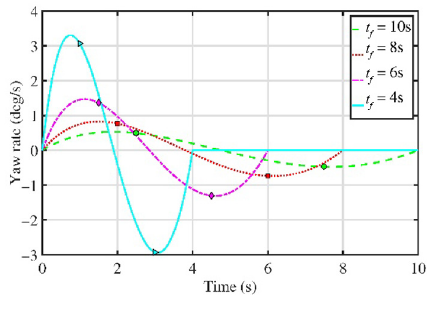
Figure 1 The constraints of the longitudinal and lateral